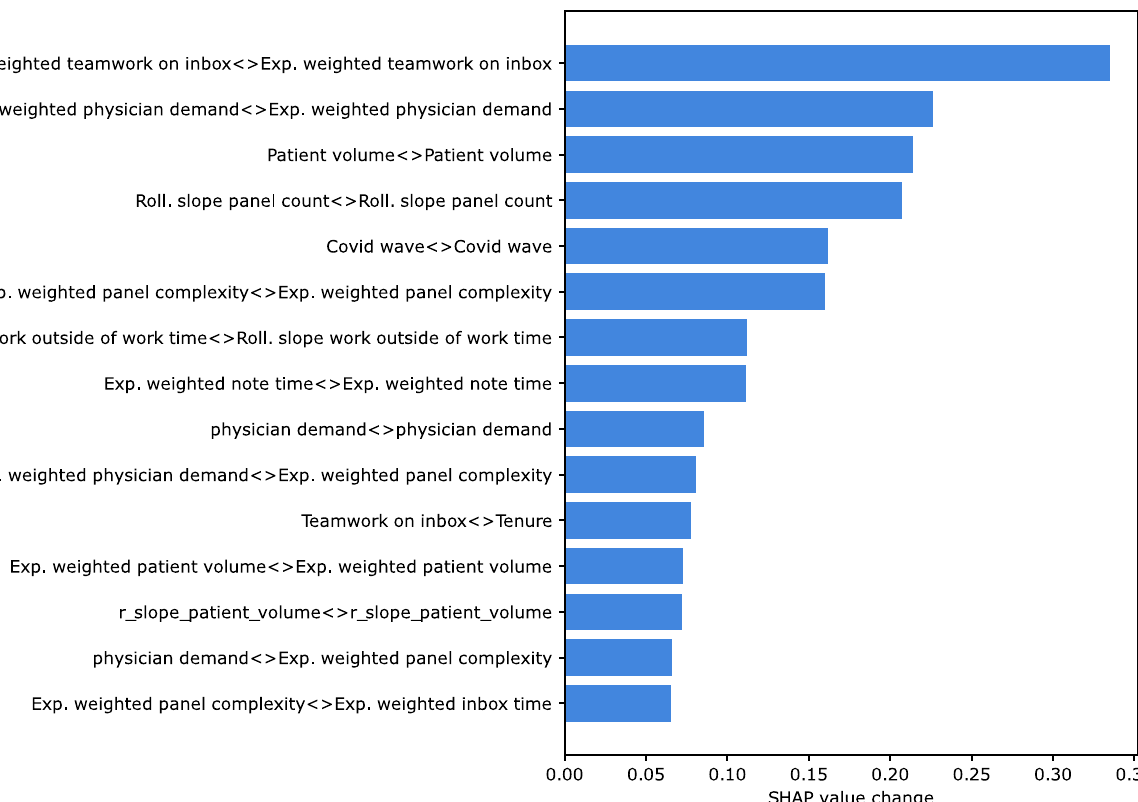
Fig 5. Features with greatest SHAP value change when physician classification changed. The top 15 values for average per-physician change in log-odds contribution for each feature and pairwise interaction as estimated by SHAP are displayed.